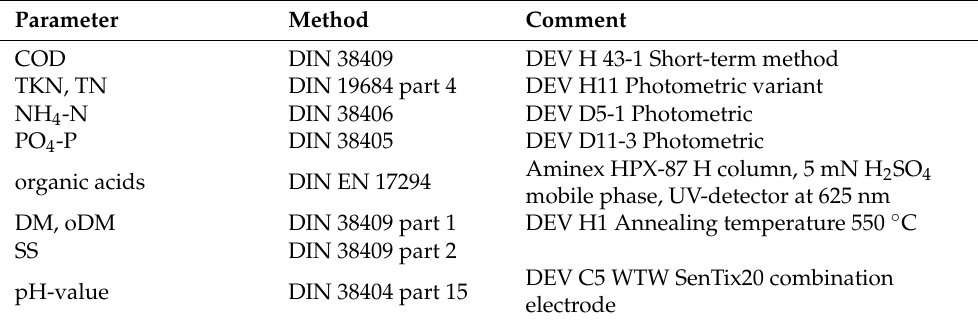
Table 4. Applied methods for chemical standard